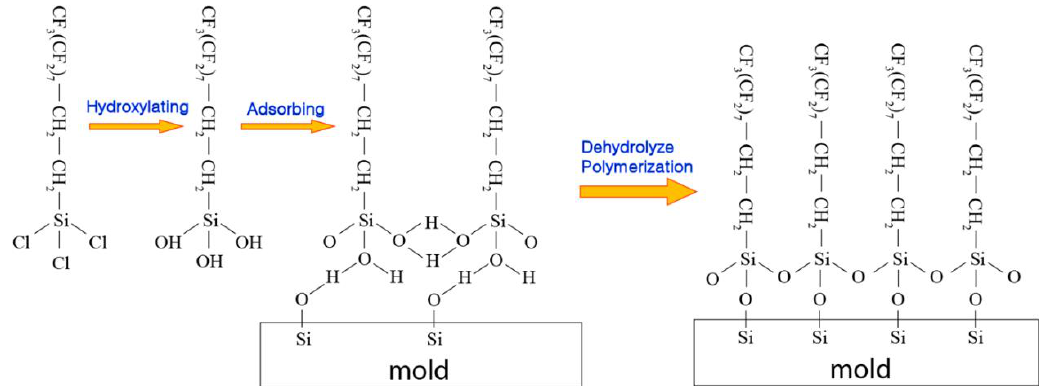
Figure 6. Schematic process showing 1H,1H,2H,2H-perfluorodecyltrichlorosilane (FDTS) monolayer ideally self-assembling on the oxidized silicon surface. By converting the mold surface silanols into inert and hydrophobic –CF 3 groups with FDTS, adhesion and friction forces can be significantly reduced through bonding site elimination and surface lubrication.